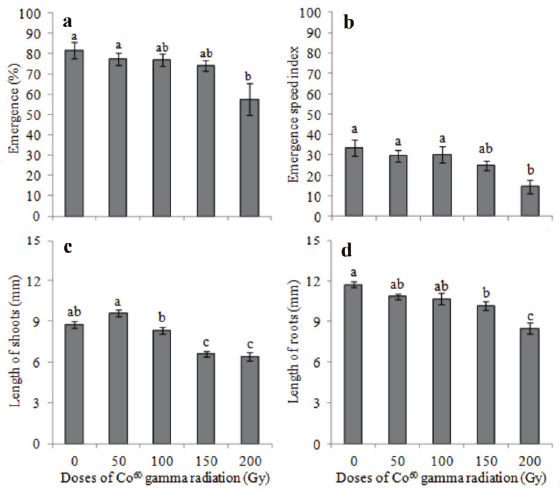
Figure 2 - Emergence ( a ), Emergence speed index ( b ), length of shoots ( c ) and length of roots ( d ) of castor bean seedlings exposed to diff erent doses of Co 60 gamma radiation. Means followed by diff erent letters diff er according to Tukey’s test (P<0.05). Bars represent the standard error of the mean of four replications.